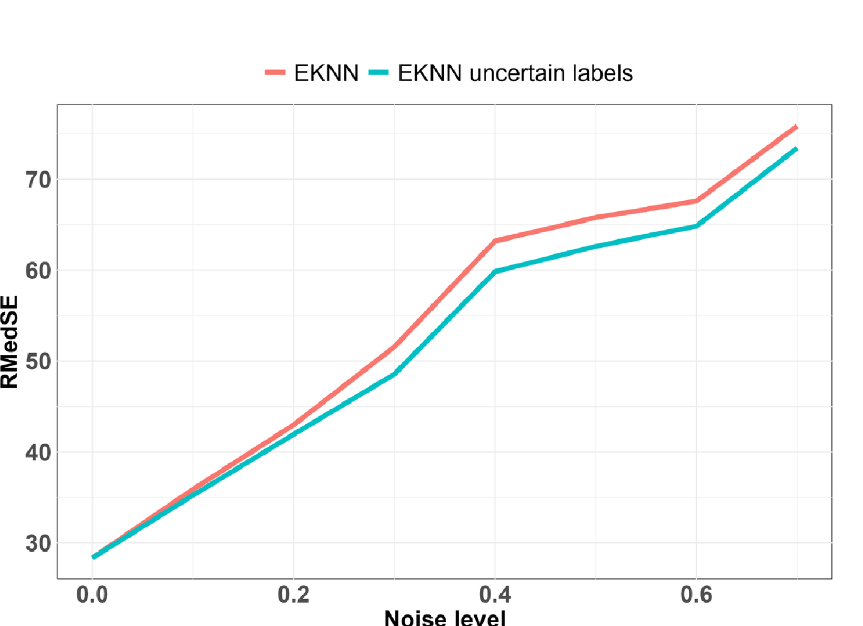
Fig 4. Predictive performances relative to noise levels for data imputed with LOCF imputation method: K = 10: z = 4.